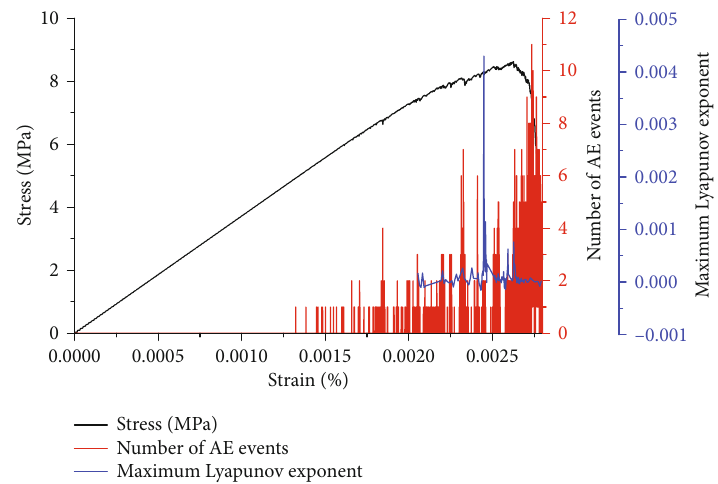
Figure 11: Stress-strain-number of AE events-maximum Lyapunov exponential variation diagram of specimen 8.